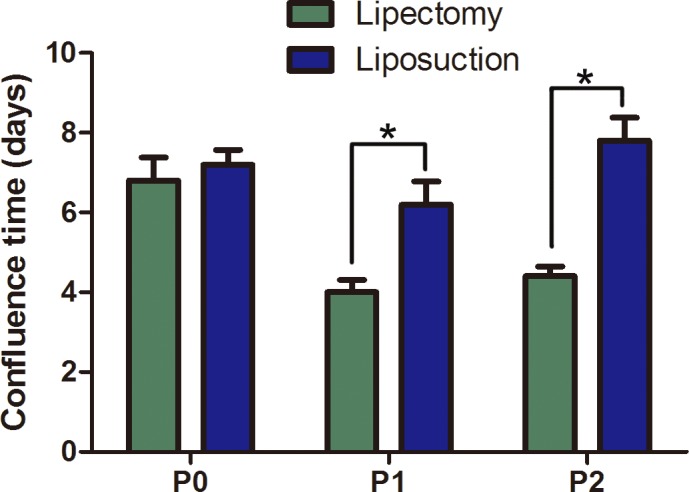
Cell confluence time of ADSCs from lipectomy and liposuction (n = 3,* p<0.05).